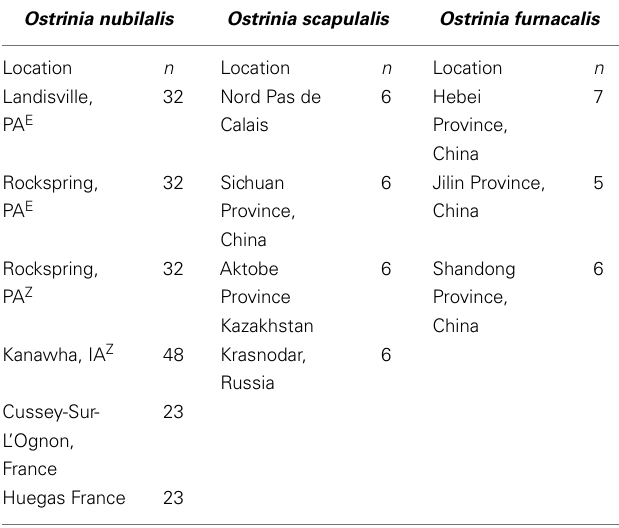
Table 1 | Ostrinia sample